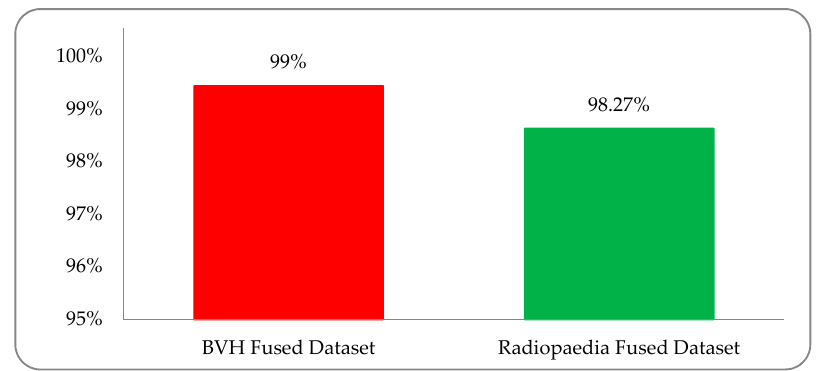
Figure 12. Comparison accuracy graph between Bahawal Victoria Hospital (BVH) and Radiopaedia fused dataset.